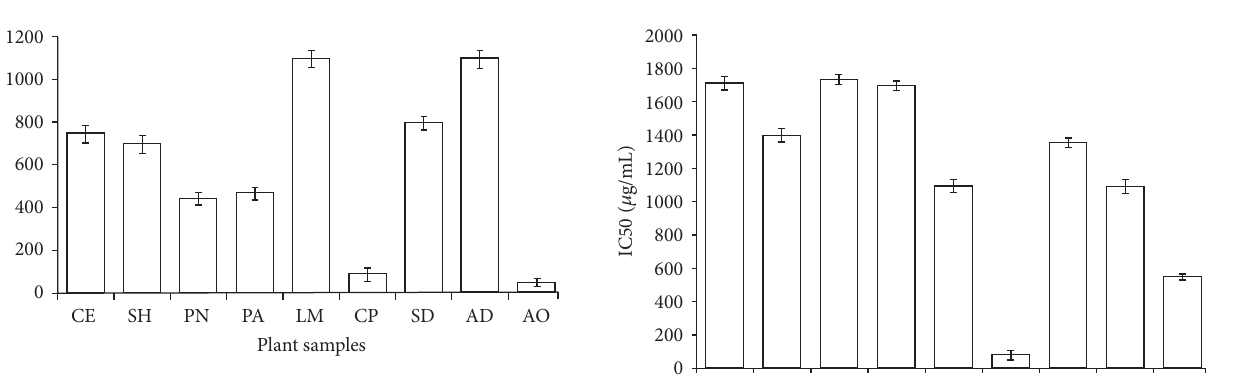
Figure 3: DPPH free radical scavenging activity of methanol crude extracts from selected antidiabetic plants used in southeast Nigeria. CE, Chlorophora excelsa ; CP, Ceiba pentandra ; SH, Strophanthus hispidus ; SD, Synsepalum dulcificum ; PN, Picralima nitida ; AD, Anthocleista djalonensis ; PA, Persea americana ; AO, Anacardium occidentale; LM, Loranthus micranthus . Results are expressed as mean ± SD ( 𝑛 = 4 ).